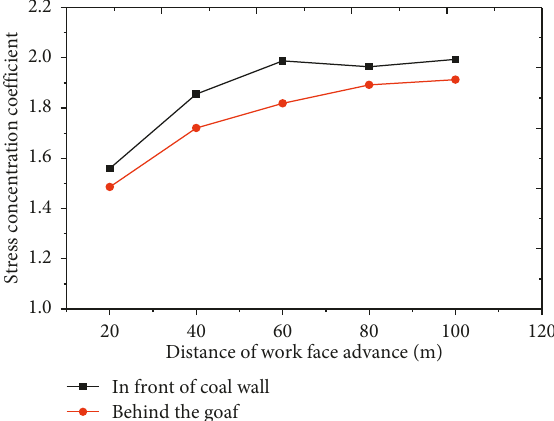
Figure 17: The stress concentration coefficients under different workface advance